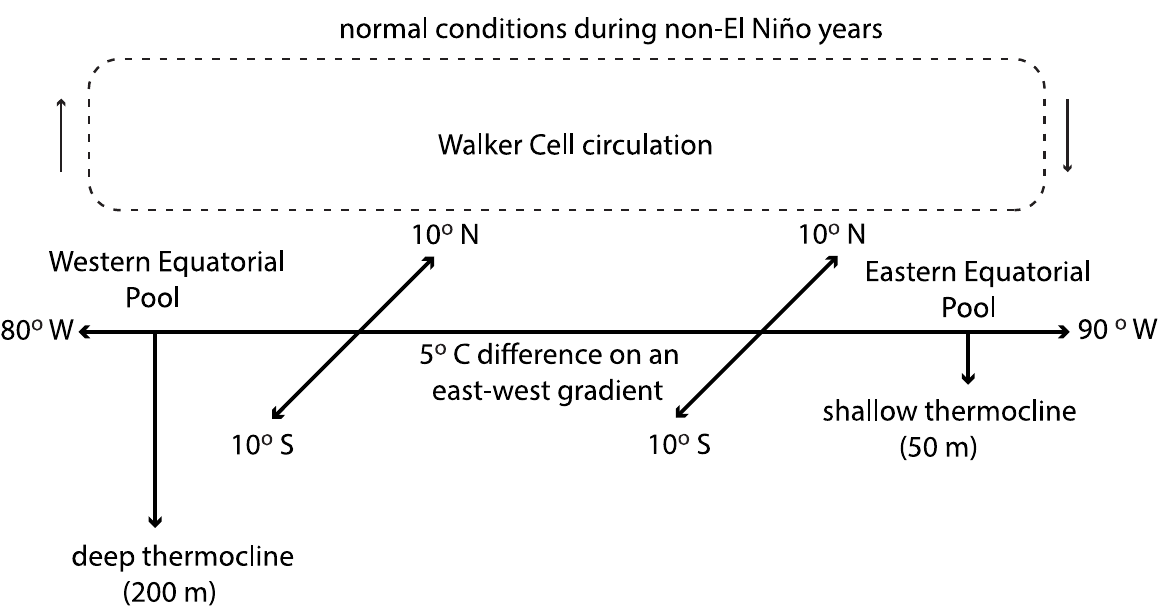
Figure 3. Sketch diagram showing the three-dimensional arrangement through the Equatorial Pacific Ocean zone under normal climatic conditions (non-El Niño years).